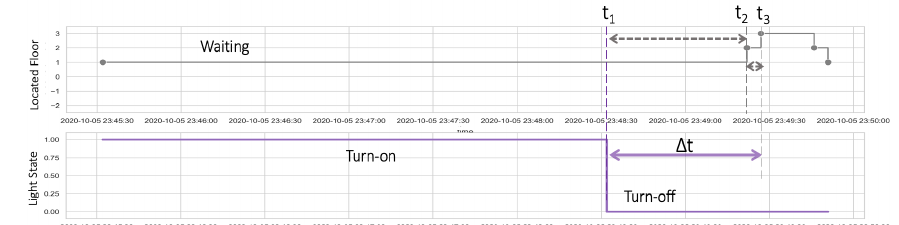
Figure 13. Example shows the real event trace of room-usage and elevator.